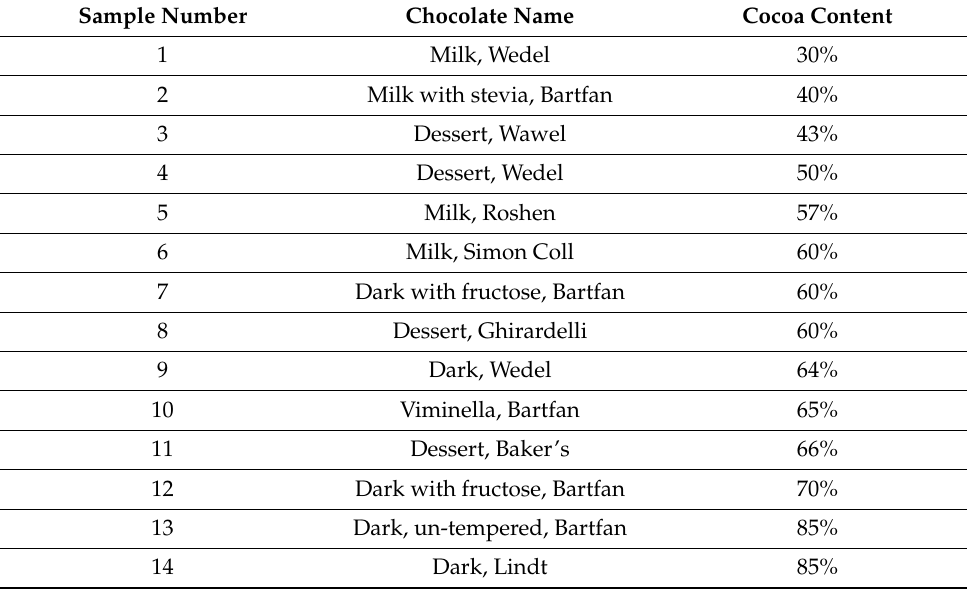
Table 1. Tested chocolates with cocoa content declared by the